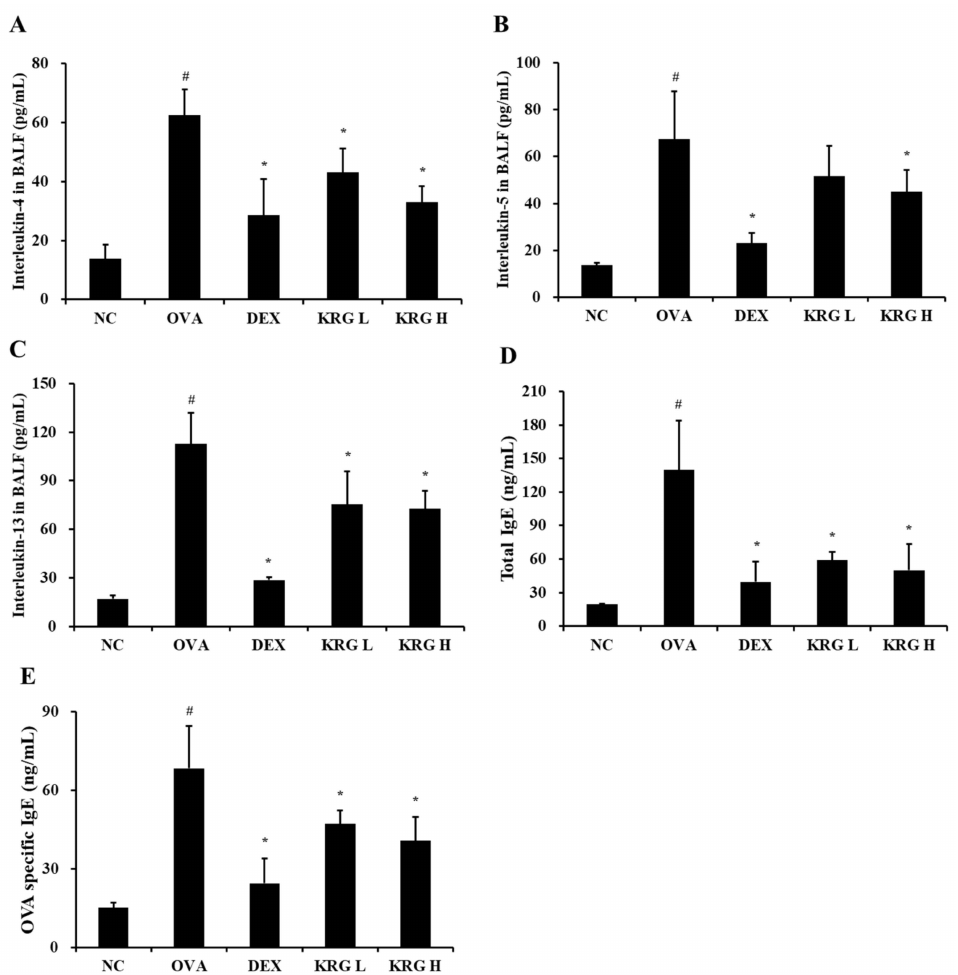
Figure 3. Korean red ginseng (KRG) reduces the elevated levels of interleukin (IL) -4 ( A ), IL-5 ( B ), and IL-13 ( C ) in the bronchoalveolar lavage fluid (BALF) and total immunoglobulin E (IgE) ( D ) and ovalbumin (OVA)-specific IgE ( E ) in the serum. Normal control (NC) group; mice administered with the vehicle, OVA, group; mice treated with OVA and administered with the vehicle, dexamethasone (DEX), group; mice treated with OVA and administered with dexamethasone (3 mg/kg); KRG low (KRG L) and high (KRG H) groups; mice treated with OVA and administered with KRG (100 and 300 mg/kg, respectively). Values: means ± standard deviation ( n = 6). Significance: # p < 0.05 vs. NC; * p < 0.05 vs.